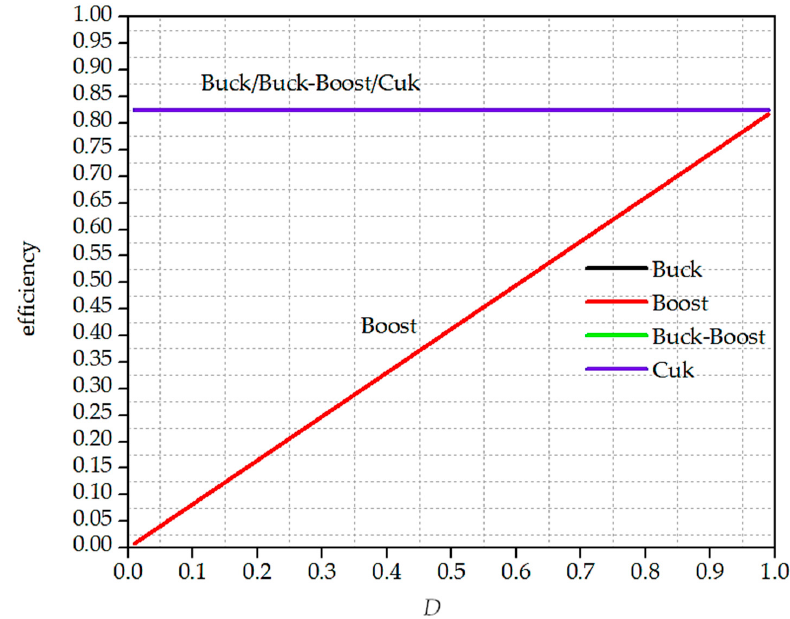
Figure 11. Relationship between efficiency and D of the LED in the diode converter.